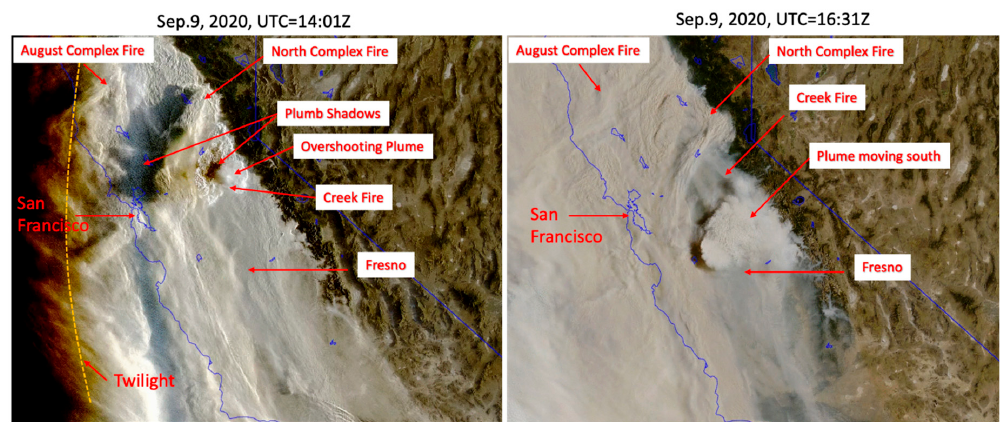
Figure 20. PyroCb generated from Creek Fire on 9 September 2020 when three major wildfires were burning in Northern California with very poor air quality and visibility in the region. The fire plumes overshot the level of neutral buoyancy and created a visible deep convective core. The plume core’s shadows on the plume deck are evident in the early morning hour. The overshooting smoke plumes allow a widespread impact of these wildfires over 1000s of kilometers (image credit: Space Science and Engineering Center at the University of Wisconsin).